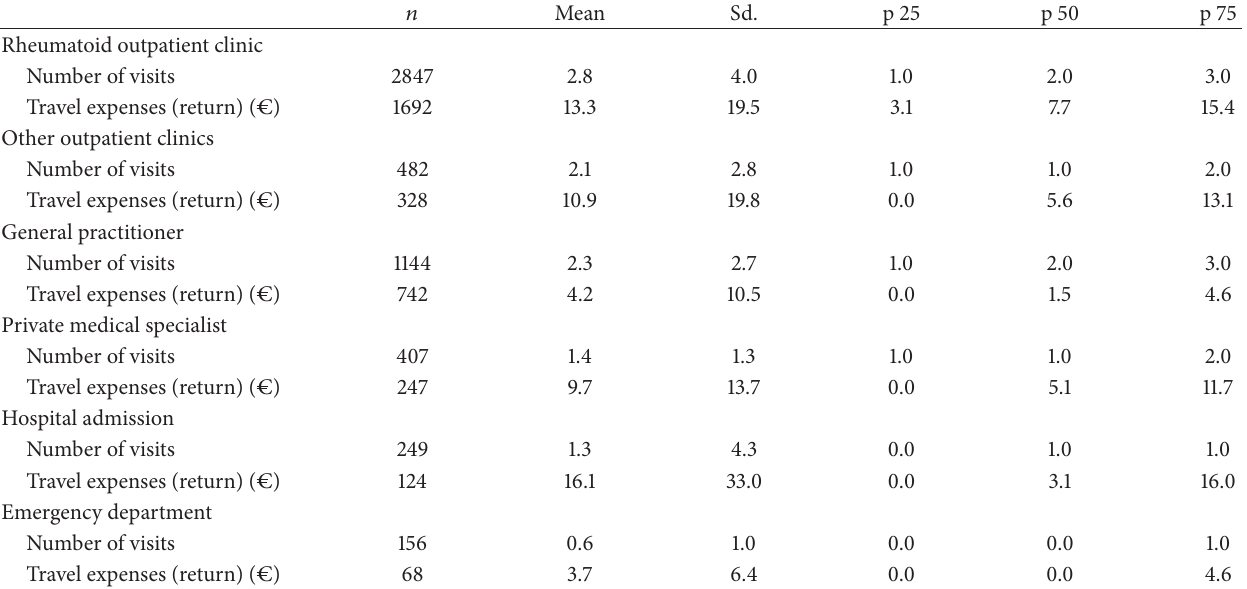
Table 2: Frequency of visits to health care providers in a 3-month period and average travel costs per visit (return trip) as reported by patients with rheumatoid arthritis.